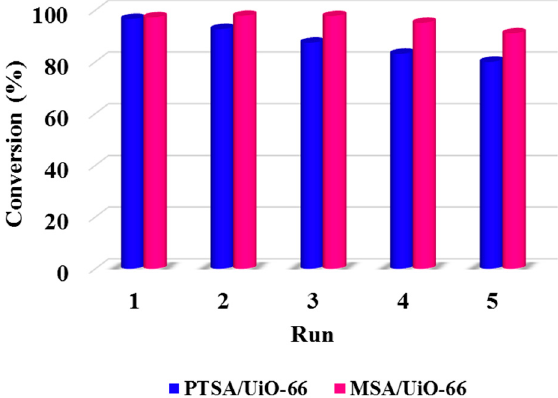
Figure 5. Two different approaches in the catalyst recovery tests.